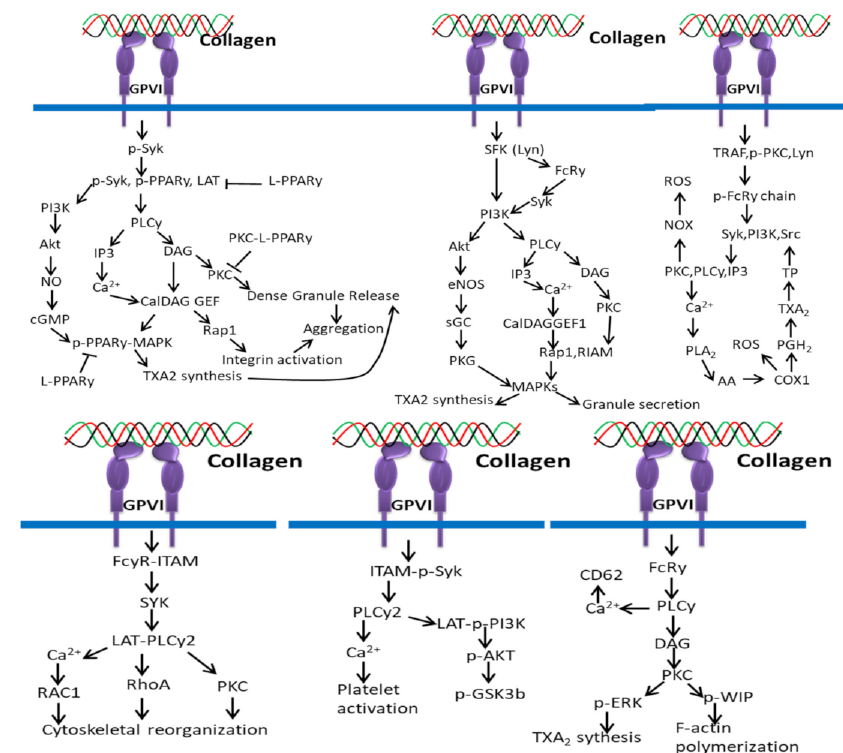
Figure 8. Collagen GPVI signals in platelets activation and ROS